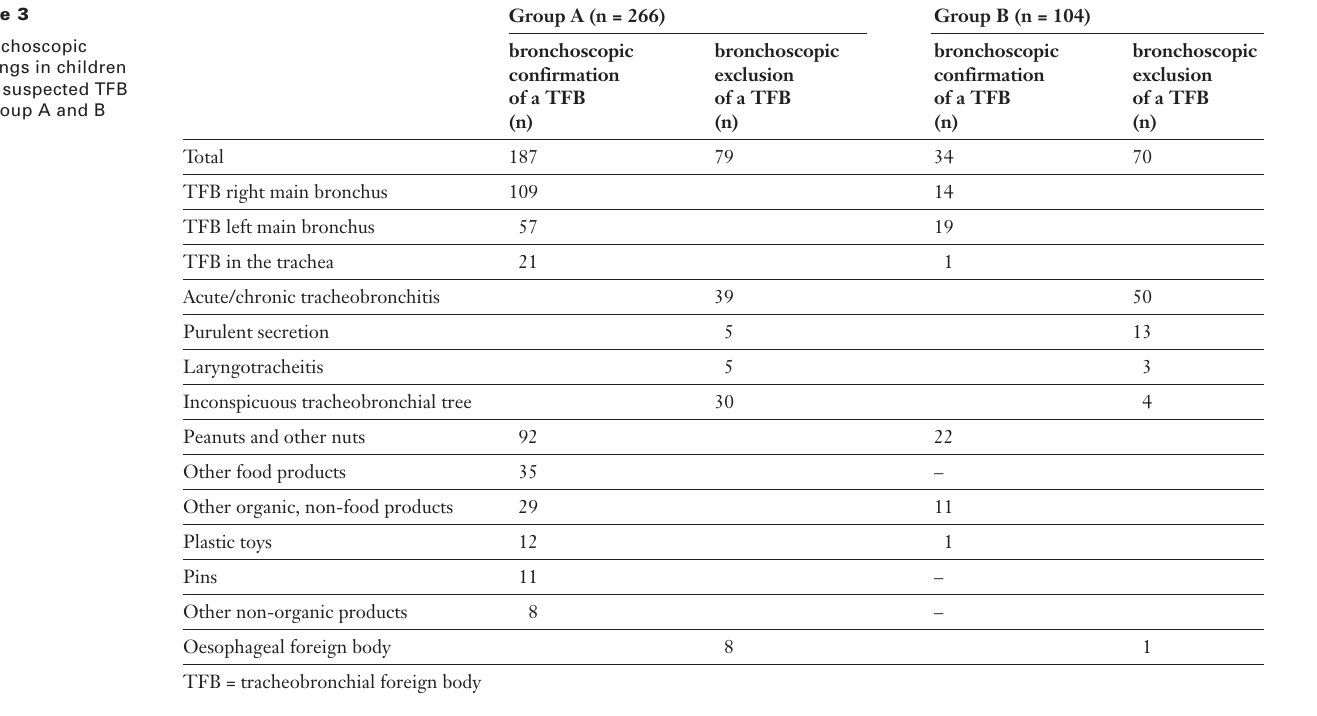
Table 4 Sensitivity and specificity of symp- toms and signs in group A and